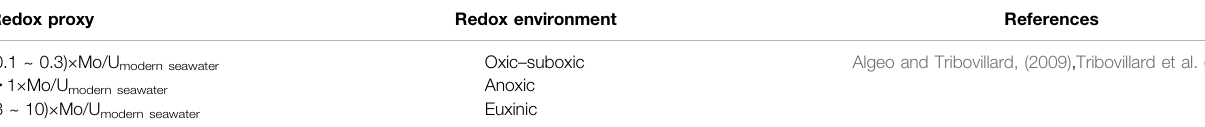
TABLE 1 | Mo EF /U EF value and associated redox environment.